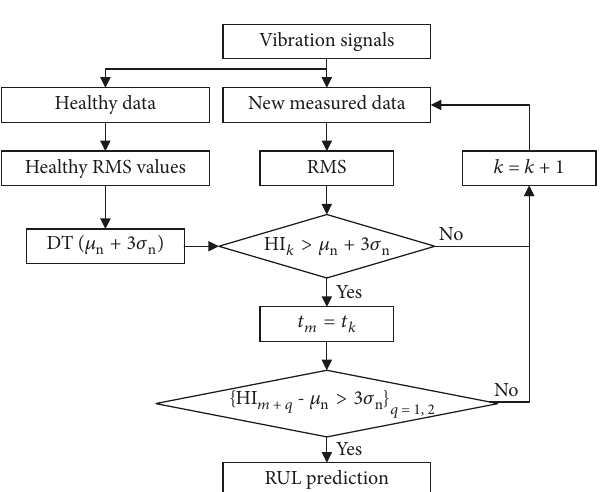
Figure 2: The degradation detection